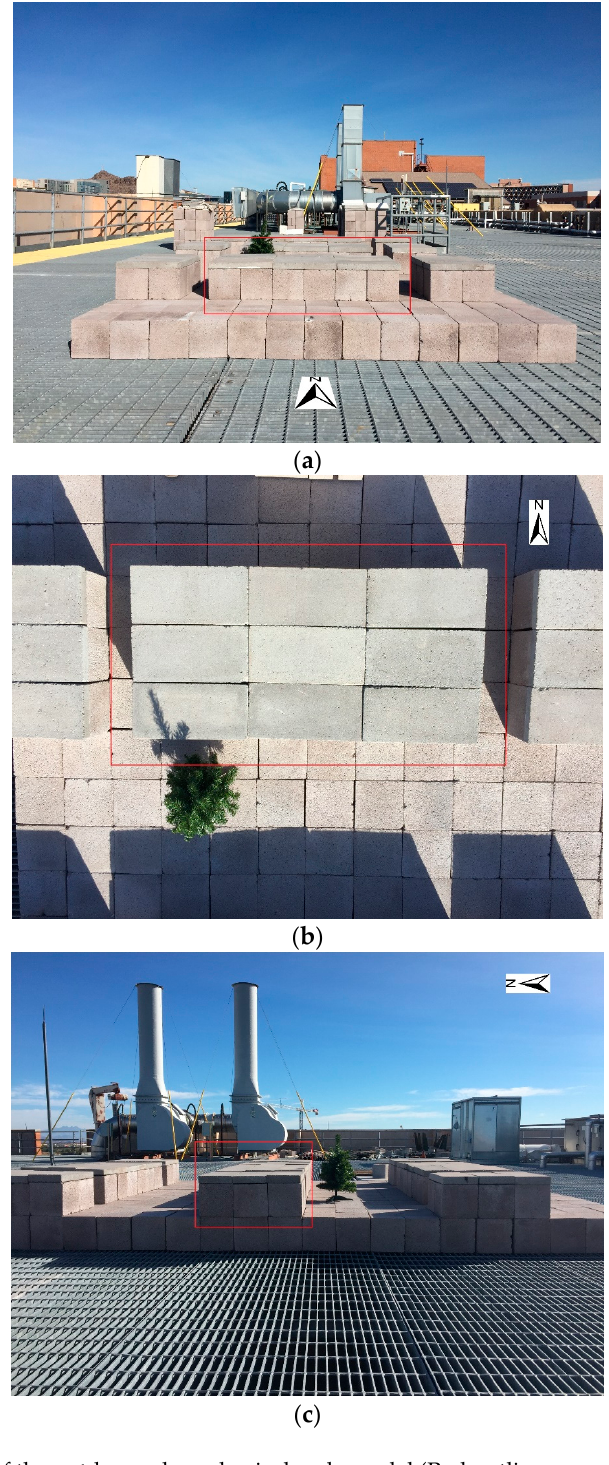
Figure 2. Pictures of the outdoor urban physical scale model (Red outline represents a single unit of the target building). ( a ) Front view; ( b ) Plan view (for one urban canyon); and ( c ) Side view.